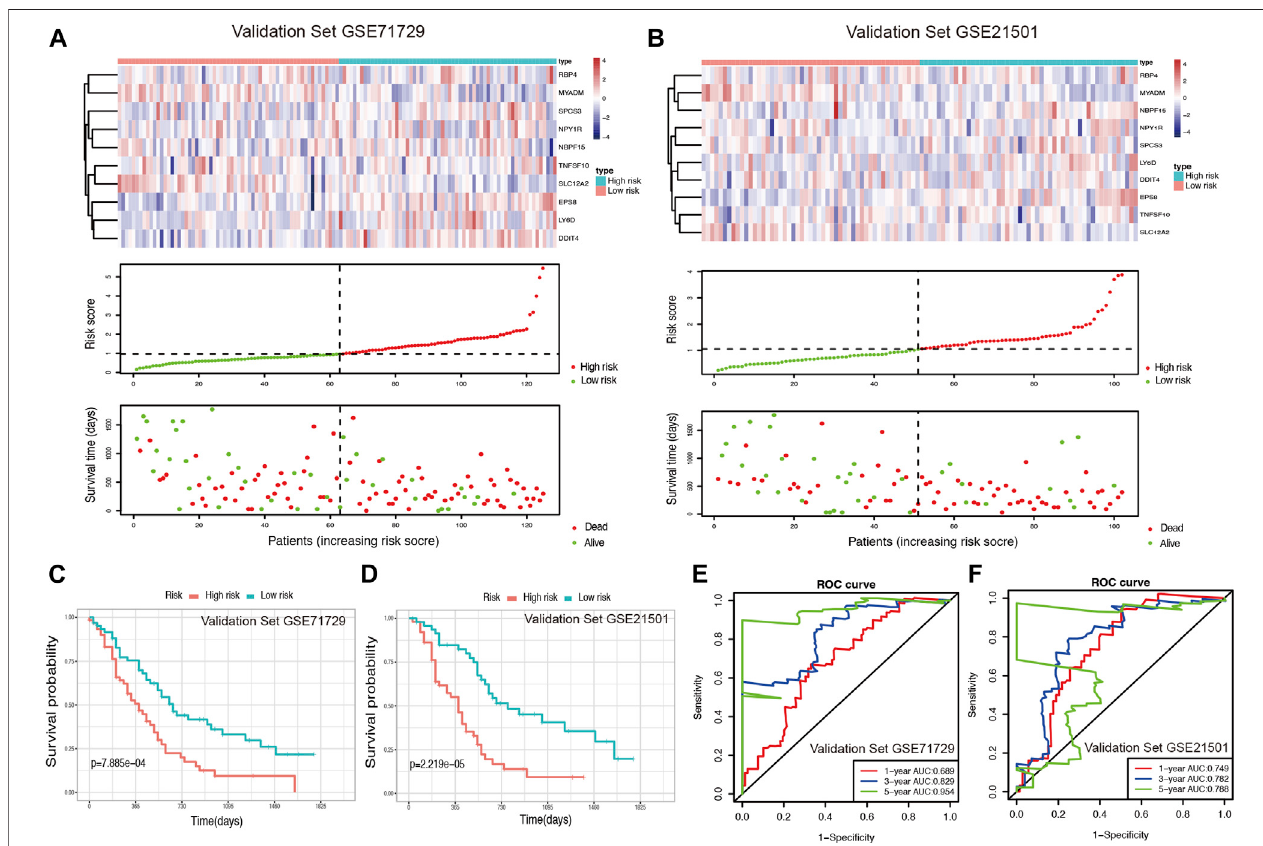
FIGURE 4 | Validation of the risk model for PDAC survival using GEO datasets. (A,B) Risk score analysis in the validation sets GSE71729 and GSE21501. (C,D) Kaplan-Meier survival curve of the risk score for patient OS in the validation sets GSE71729 and GSE21501. (E,F) The time-dependent ROC curve for predicting the 1-, 3-, and 5-years OS rates in the validation sets GSE71729 and